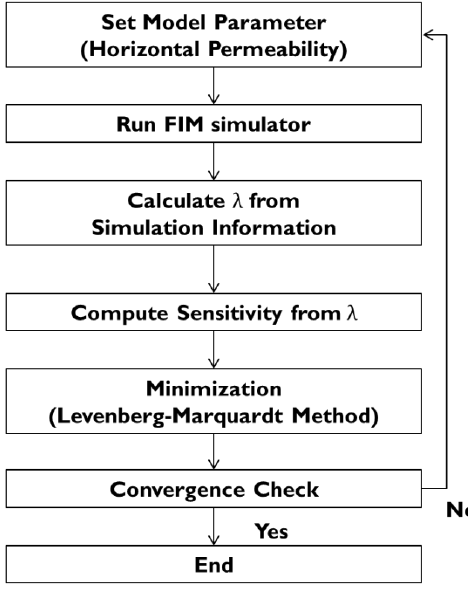
Figure 1—History matching flow